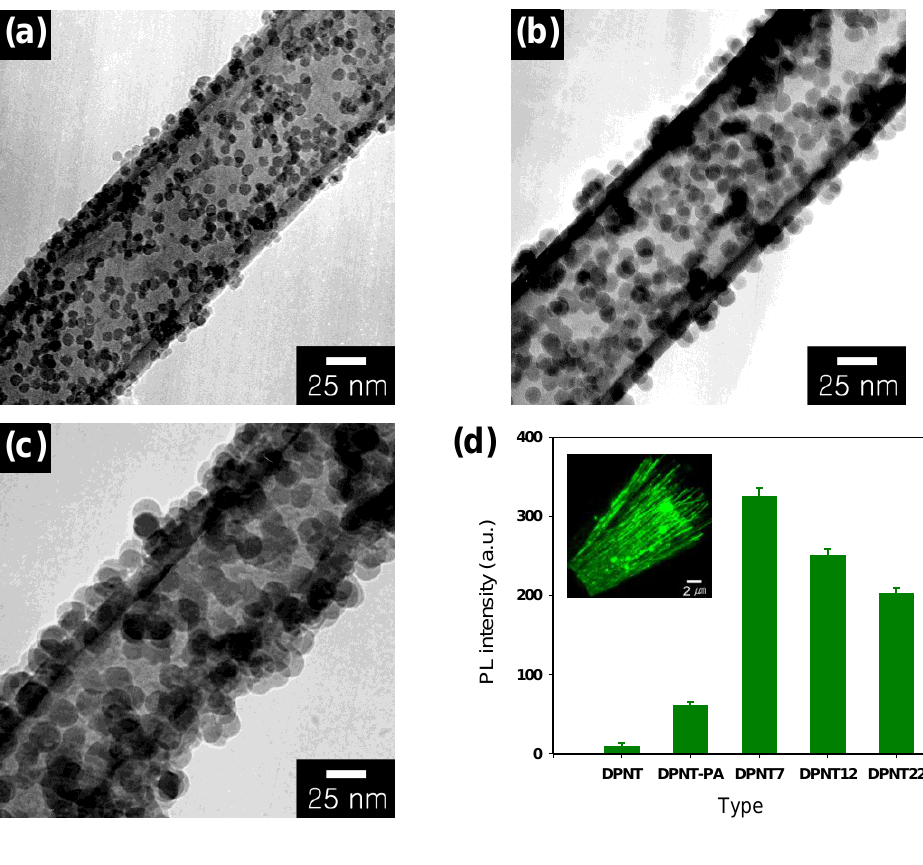
Figure 14. TEM images of PPy nanotubes with different sized amine-modified silica nanoparticles attached: ( a ) 7 nm; ( b ) 12 nm; and ( c ) 22 nm; ( d ) photoluminescence intensity of pyreneacetic acid conjugated with amine groups on the nanotube hybrids (DPNT: unconjugated PPy nanotube hybrids; DPNT-PA: the nanotube hybrid incubated with pyreneacetic acid in the absence of a condensing agent; DPNT7: the nanotube hybrids formed using 7 nm silica; DPNT22: the nanotube hybrids formed using 22 nm silica (inset: CLSM image of pyreneacetic acid conjugated with amine groups of the nanotube hybrids. Adapted with permission from [23]; Copyright 2006, Wiley-VCH Verlag GmbH & Co.